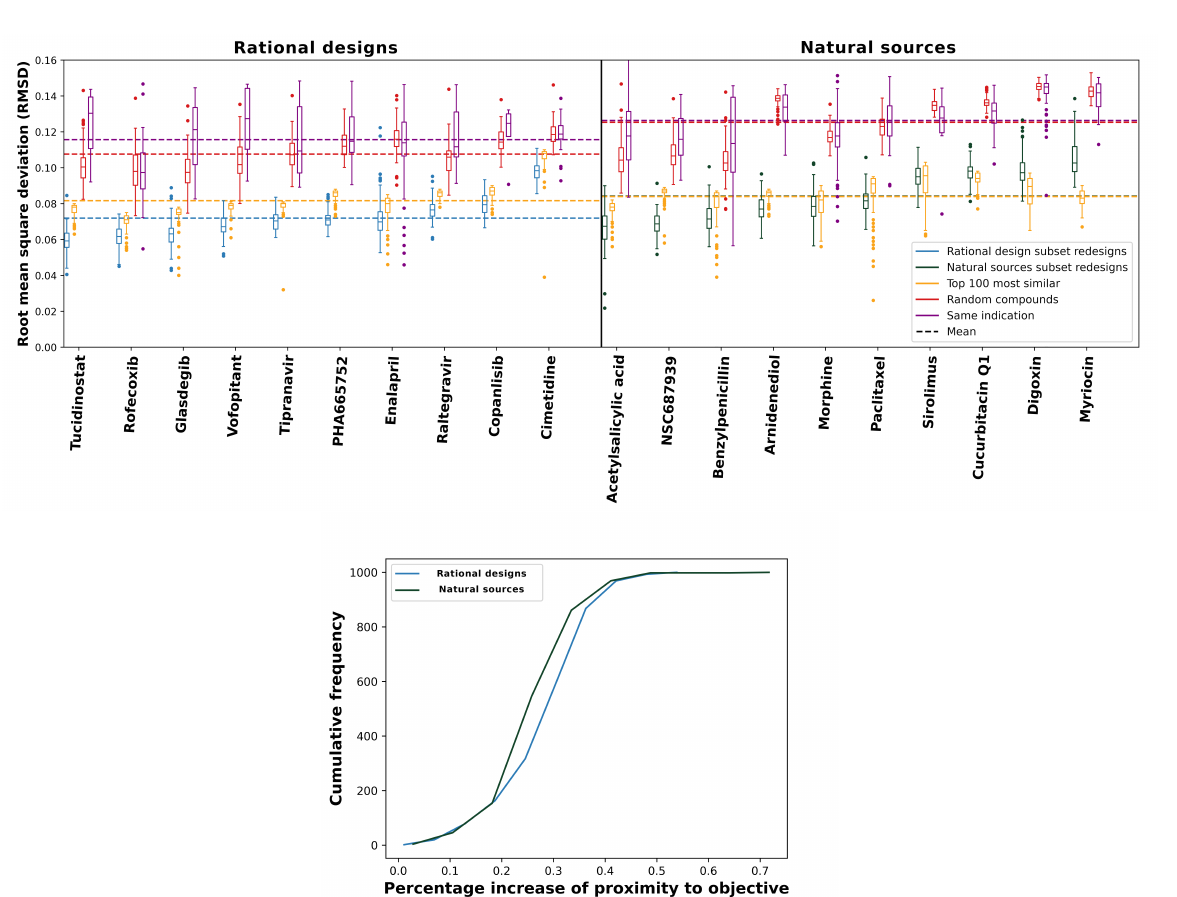
Figure 2. Performance of our deep learning drug design pipeline. To evaluate the performance of the RCVAE pipeline for drug design, we compared redesigned compounds to three controls. The root-mean-squared deviations (RMSDs) between redesigned and control interaction signatures for the rational design and natural sources subsets and the corresponding objective signatures were used to evaluate the performance, as a proxy for behavioral similarity. In the top panels, the blue and green box plots denote the distributions of RMSDs between predicted proteomic interaction signatures for 100 redesigns and the ten corresponding objectives from the rational design (left) and the natural sources (right) subsets along the horizontal axis, respectively. For each RMSD distribution box plot, the boxes indicate the first and third quartile ranges, the horizontal bar indicates the median, and the whiskers indicate non-outlier ranges, with outliers plotted as dots. As a naive control, the red box plots in both panels denote the distributions of the RMSDs between predicted proteomic interaction signatures for a set of 100 randomly selected drug-like compounds taken from the ZINC database [54] and the corresponding objectives. Yellow box plots denote the distributions of the CANDO-predicted top 100 most similar compounds by interaction signature and their corresponding RMSDs; this is a more rigorous control, which checks to see if there exists any compound in the CANDO library that could match or exceed the performance of the design pipeline. Purple box plots denote the RMSD distributions of compounds approved for the same indication as the objective; this is a third control based on phenotype. Dots represent RMSD values for outlier points for each distribution. Dashed lines show the average RMSDs of all compounds corresponding to a given color. All redesign–control distribution pairs were significantly different as indicated by Kolmogorov–Smirnov (K-S) tests and outperformed random controls. For 16/20 of the objective compounds, our redesigns were able to perform better than the top 100 and same indication controls (medians and distributions). The exceptions were four compounds from the natural sources subsets (sirolimus, cucurbitacin Q1, digoxin, and myriocin), discussed further in Sections 2.2 and 2.4. The bottom panel displays cumulative frequency graphs of percentage increases of similarities (“proximity”) to the objective for rational design and natural sources subsets redesigns (see the Materials and Methods Section 3.3). Redesigns from the former subset were significantly more accurate to the objective compound than the natural sources subset when compared to the naive control, with mean percentage similarity increases of 33.4% and 32.9%, respectively ( p -value ≤ 7.0 × 10 − 6 ). This indicates that not only does the design pipeline generate compounds with the desired proteomic-scale behavior, but that it likely implements a learned abstraction of rational drug